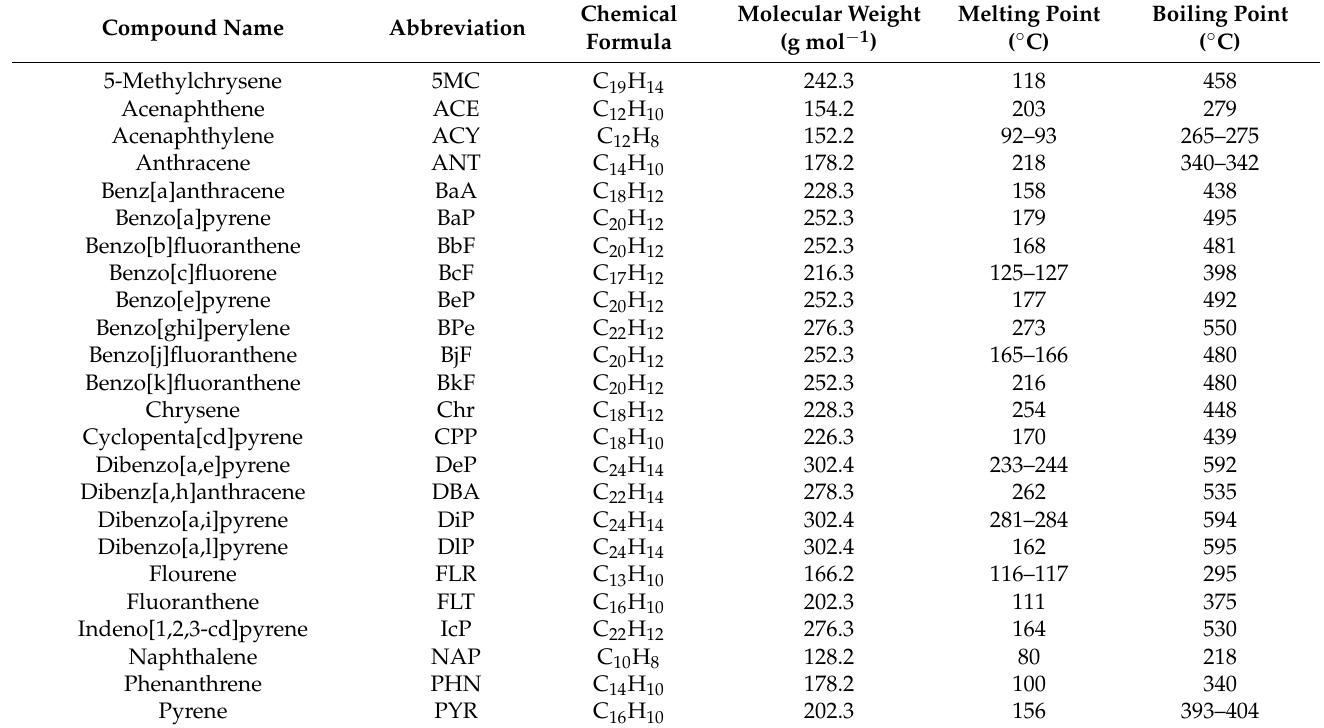
Table 1. Chemical and physical properties of polycyclic aromatic hydrocarbons present in